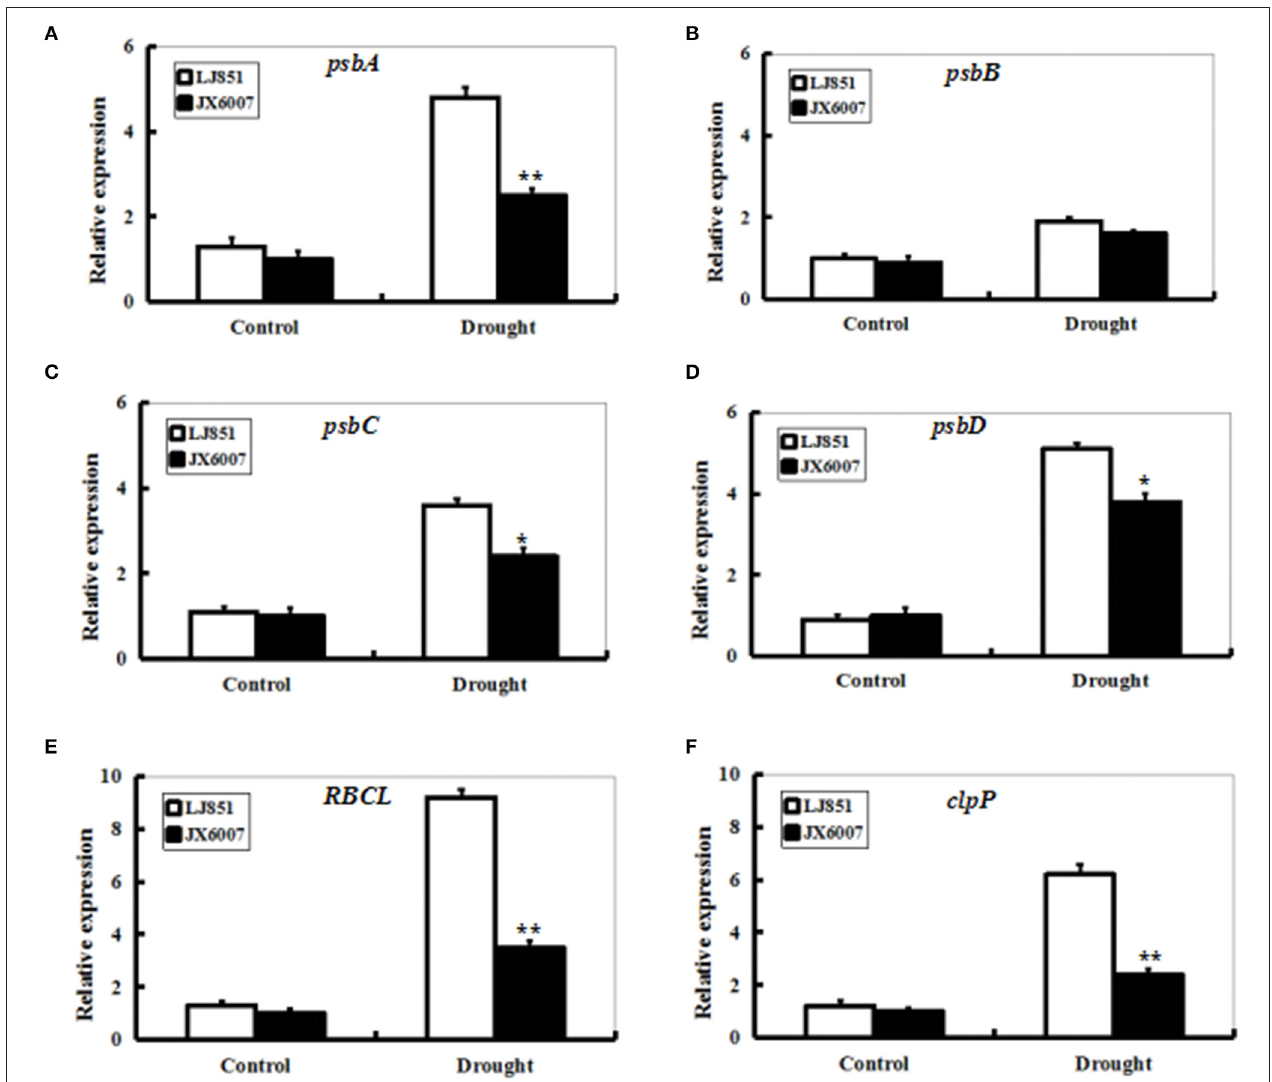
FIGURE 6 | Expression profiles of genes for photosynthesis-related proteins in both types of tobacco plants after drought stress. RNA was extracted from stressed leaves sampled after 10 days of drought treatment and reverse-transcribed to synthesize cDNA, which was used for qPCR analysis with primers specific for six photosynthesis-related genes psbA (A) , psbB (B) , psbC (C) , psbD (D) , RBCL (E) , and clpP1 (F) . Data represented means ± SE of three biological replicates. Bar indicates SE. ** t -test, with P < 0.01; * t -test, with P <